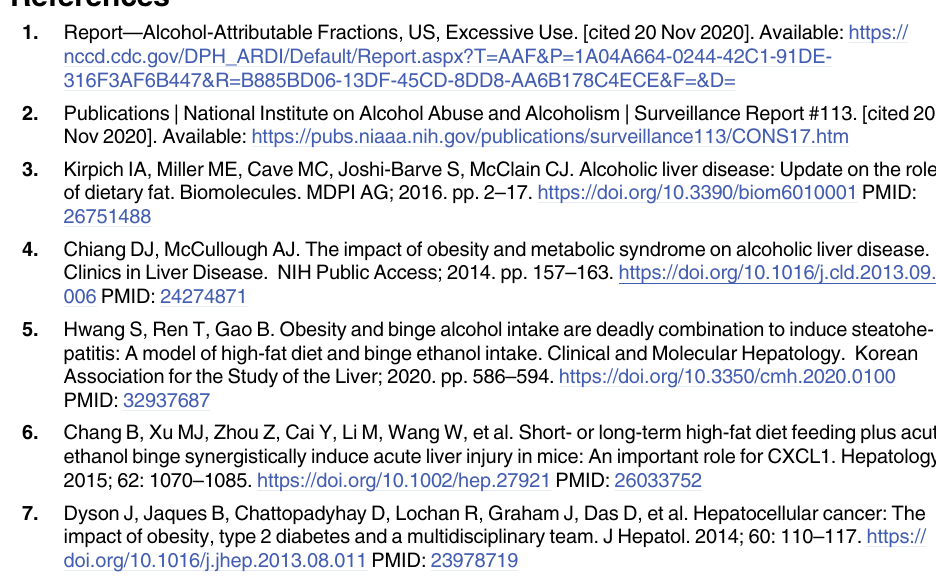
S1 Fig. Quantification of inflammation and fibrinogenesis in WASH-diet pair-fed control mice display. A. IHC expression of TGFB in vehicle and SR9238 treated WASH-control diet fed mice. B. IHC expression of IL6 in mice receiving the WASH-control diet and dosed with vehicle or SR9238 C. PicoSirius Red staining showing lack of hepatic collagen deposits in livers of WASH control mice treated with SR9238 or vehicle. Immunohistochemistry was performed as described in the materials and methods